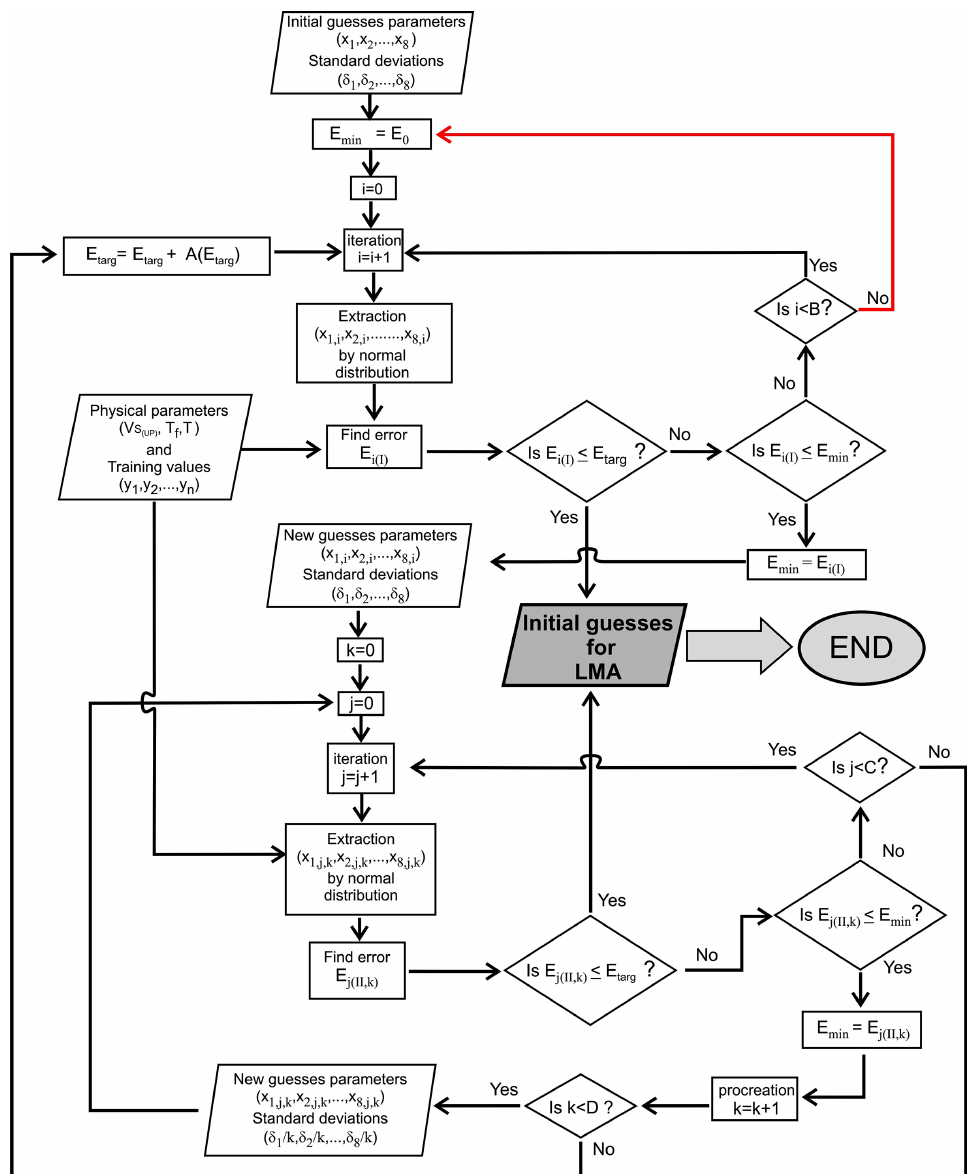
Figure B1. The evolutionary algorithm (EA) scheme: x and δ are the mean and the standard deviation in normal distribution; I and II indicate the first and the second phase; i,j are the generic populations; k is the ranking of the generation in the second phase; E 0 is the initial error (100); E min is the current error; E targ is the initial error target, it depends on the number of lithodynamic units in the V S – h trainer model and the number of trainer models (0.005 to 0.05); A is the increased ratio of the E targ (0.02); B is the number of the generated population (2000) before the mass extinction (red flow line); C is the max number of populations permitted in a generation of the second level (100); D is the number of the generation in the second phase